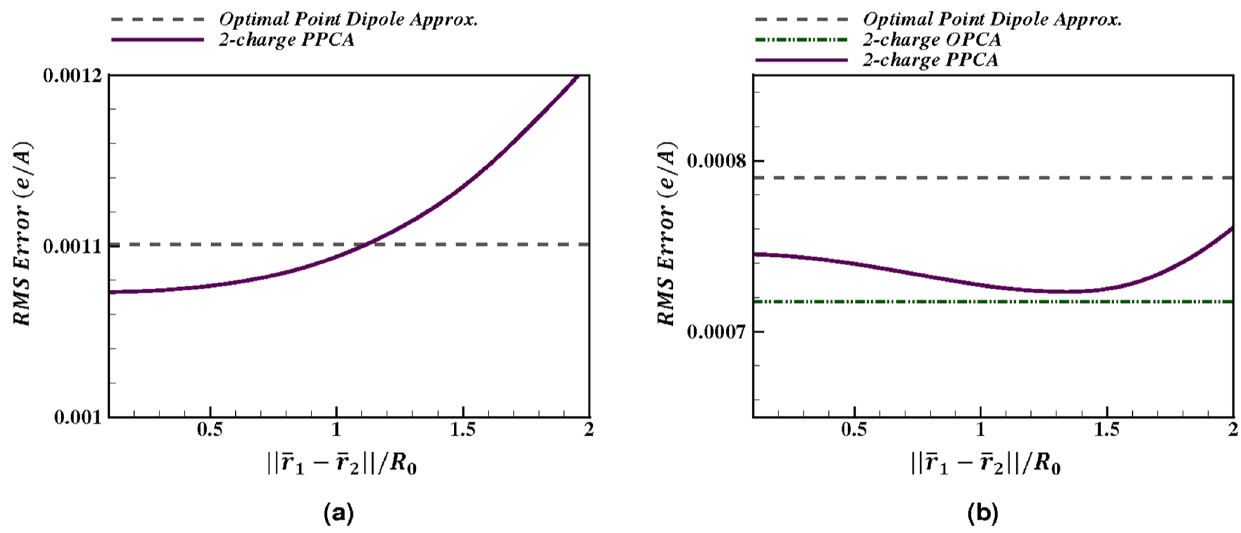
Figure 2. Accuracy of the 2-charge practical point charge approximation (PPCA) for charge distributions with a net zero charge. Accuracy is calculated as the RMS error relative to the exact computation, at a distance of 10 A˚ ( & 2 R 0 ) from the center of geometry. RMS error for the 2-charge PPCA (Eq. (18)) is shown as a function of the distance between the two charges of the PPCA DD (cid:2) rr 1 { (cid:2) rr 2 DD . The RMS error for the 2-charge PPCA is compared to that of the point dipole approximation with an optimal center of expansion. ( a ) Cases where Eq. (23) is true. ( b ) Cases where Eq. (23) is false. This figure also includes the 2-charge optimal point charge approximation (Eq. (22)) for comparison. Connecting lines are shown to guide the eye.